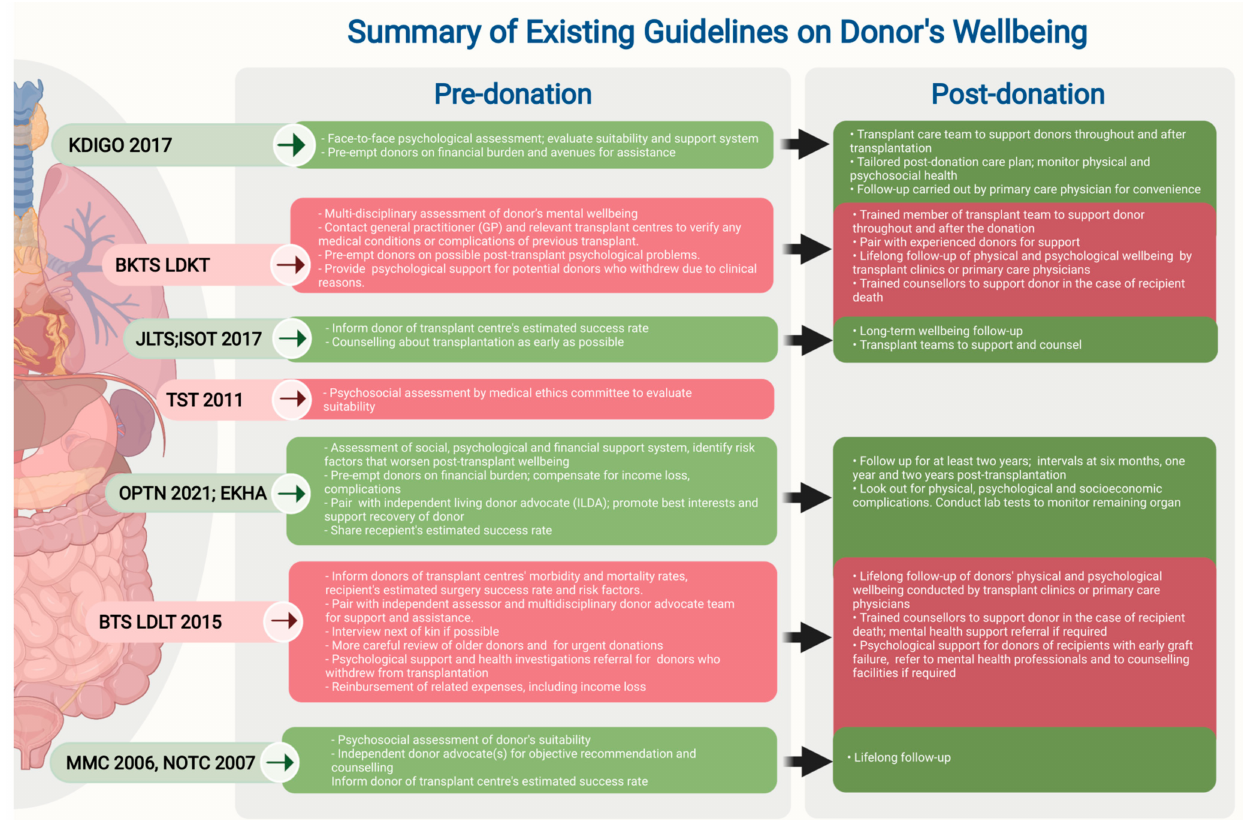
Figure 1. Summary of Existing Guidelines on Donor’s